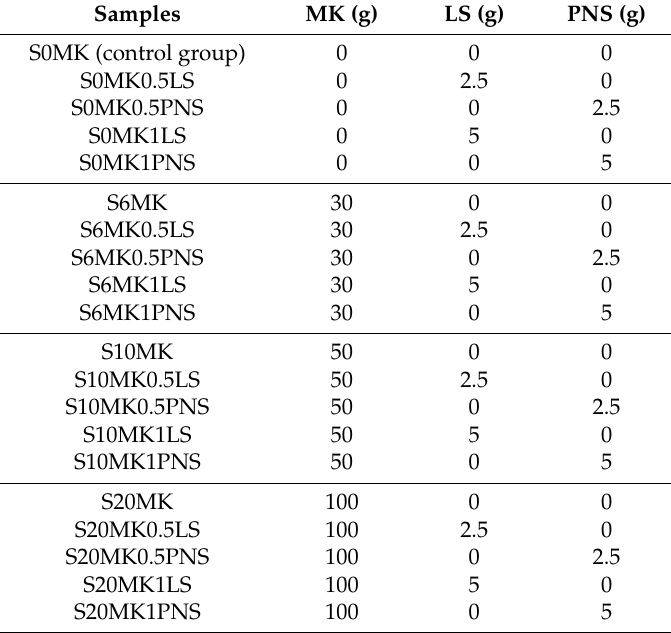
Table 1. Composition of the different grouts (all of them were prepared with 500 g of air lime, 1500 g of calcitic sand, and 500 g of mixing